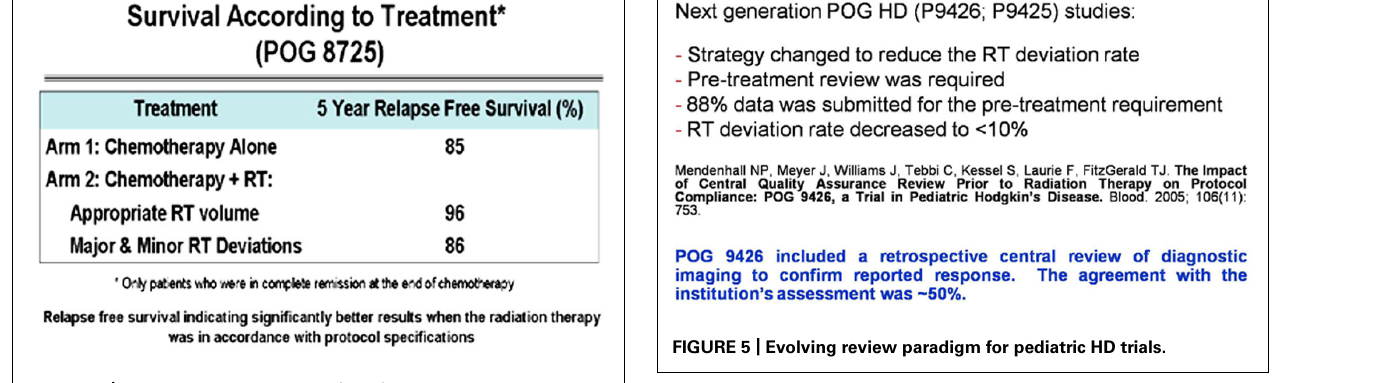
FIGURE 4 | Pediatric Oncology Group (POG) Protocol 8725 Survival according to treatment. Figure originally published in FitzGerald etal. (2008).